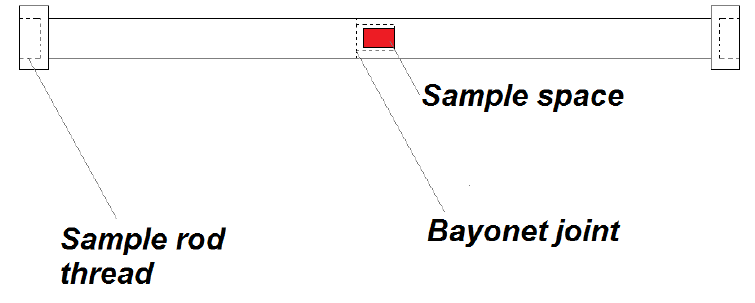
Figure 5. Schematics of high-density polyethylene sample holder configuration.